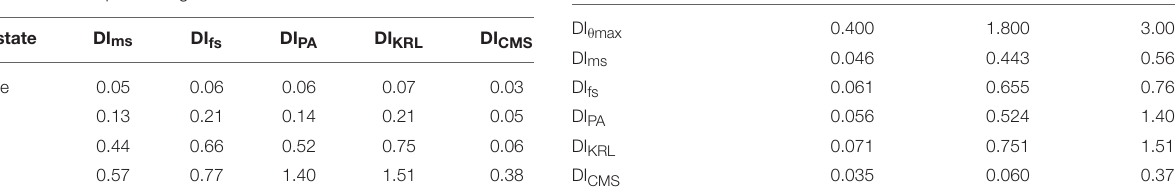
TABLE 1 | 2D test example-Damage state with reference to crack width.